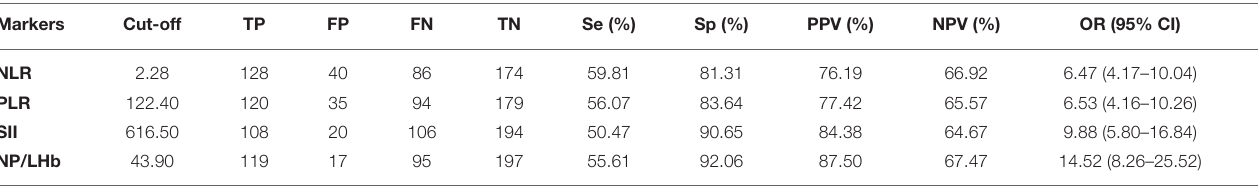
NLR, neutrophil/lymphocyte ratio; PLR, platelet/lymphocyte ratio; SII, systemic immune-inflammation index; NP/LHb, neutrophils x platelets/lymphocytes x hemoglobin ratio; TP, true positive; FP, false positive; FN, false negative; TN, true negative; Se, sensitivity; Sp, specificity; PPV, positive predictive value; NPV, negative predictive value; OR, odds ratio; CI, confidence